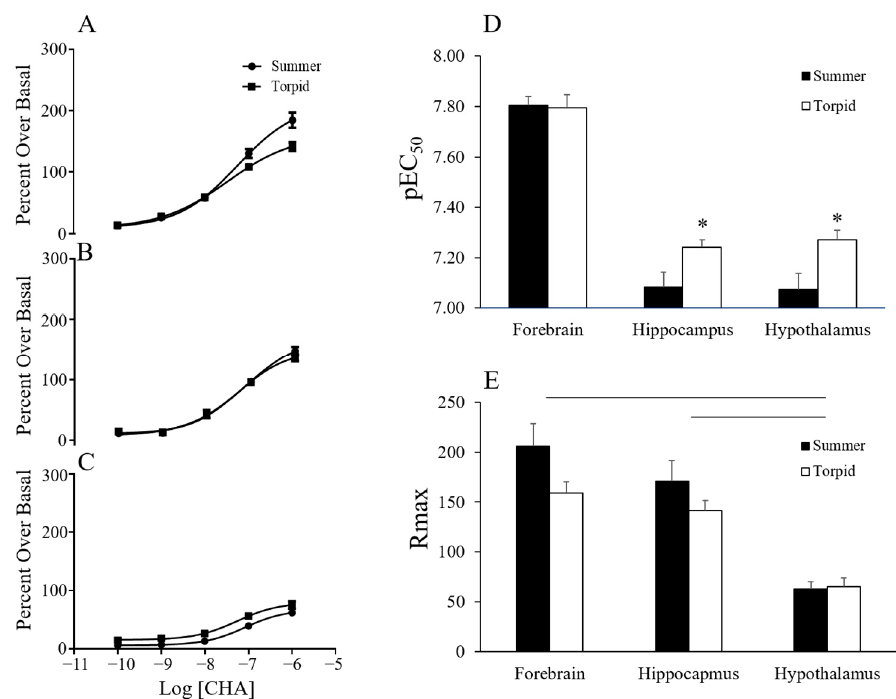
Figure 3. CHA-induced 35 S-GTP γ S binding in summer and torpid AGS brain tissue. Three brain tissues were analyzed: forebrain (n = 6, 5; summer, torpid) ( A ), hippocampus (n = 7, 7; summer, torpid) ( B ) and hypothalamus (n = 7, 6; summer, torpid) ( C ). ( D ) An increase in pEC 50 indicates an increase in the potency of CHA in the hippocampus and hypothalamus in torpid vs. summer AGS; * p < 0.05, t -test. Horizontal lines in ( E ) indicate differences between groups, p < 0.05.